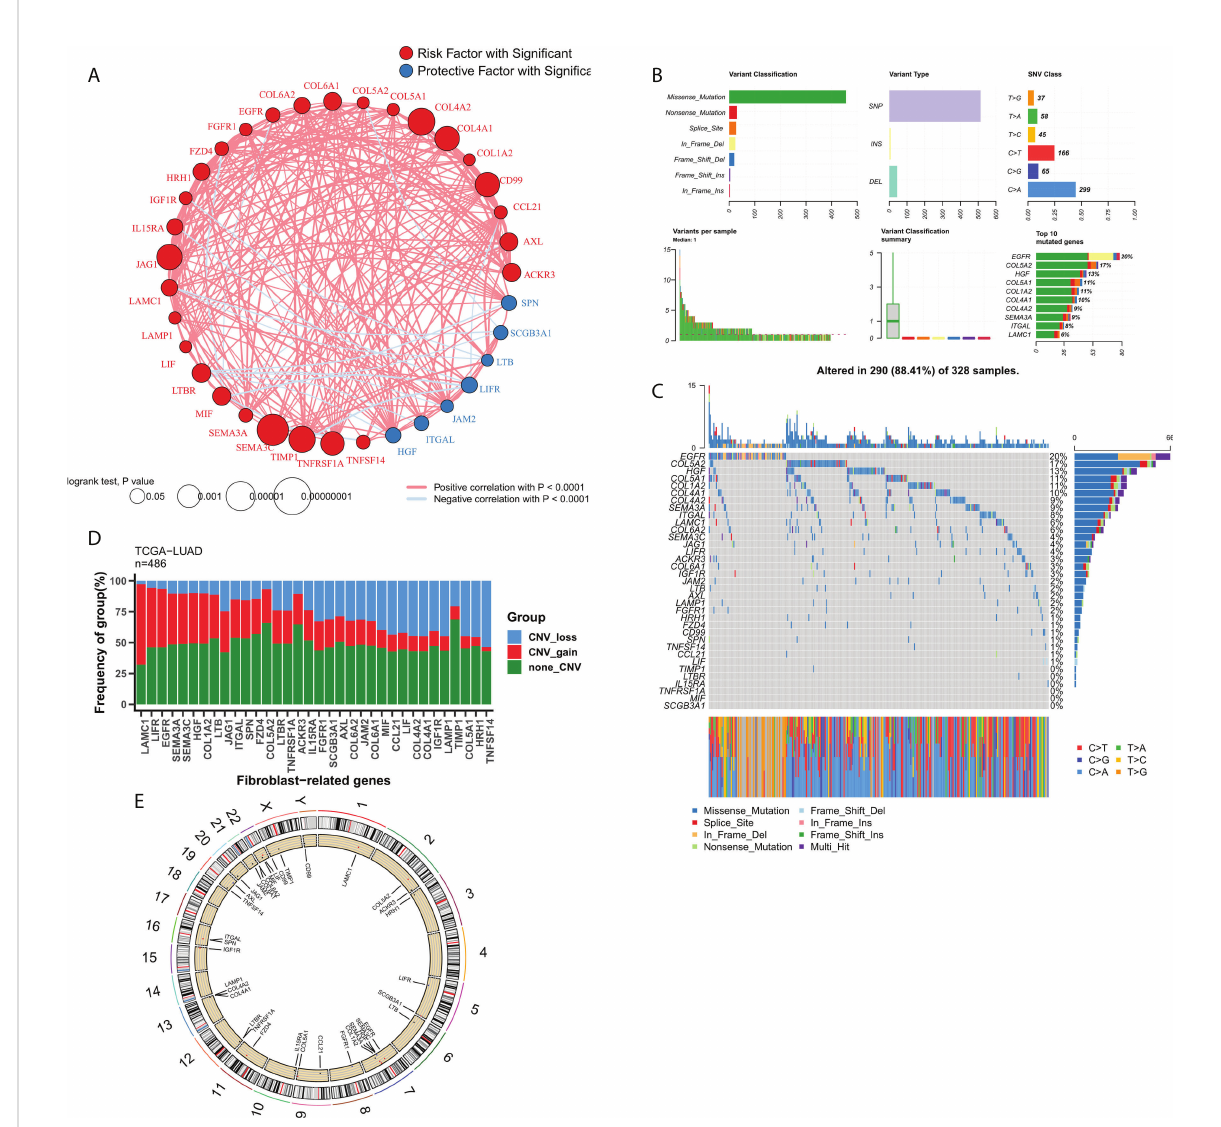
FIGURE 2 Genomic pro fi le of FRGs in LUAD. (A) Correlation network of FRGs; (B) Summary of mutational events for FRGs in TCGA-LUAD; (C) Oncoplot showing the mutational mapping of FRGs; (D) Summary of CNV events for FRGs in TCGA-LUAD; (E) A loop graph showing CNV events for FRGs on